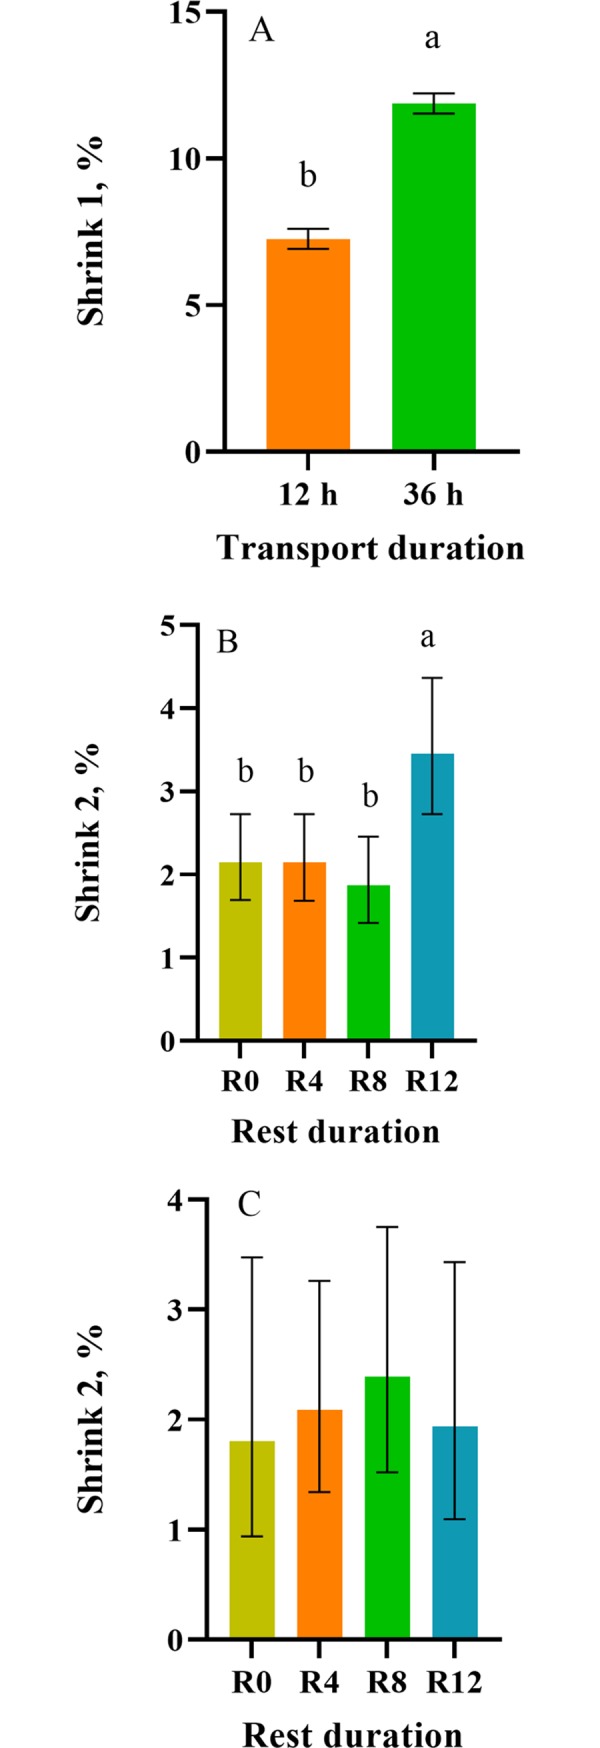
Least square means (± upper and lower limits) of shrink % of conditioned black Angus and black Simmental calves.Shrink % of calves after the initial 12 and 36 h transportation, (B) shrink % of calves receiving 0, 4, 8, and 12 h rest after the additional 4 h transport and (C) shrink % of a subset of 10 calves/treatment receiving 0, 4, 8, and 12 h rest after the additional 4 h transport taking feed intake into account. a-bLeast square means with differing superscripts differ (p ≤ 0.05).